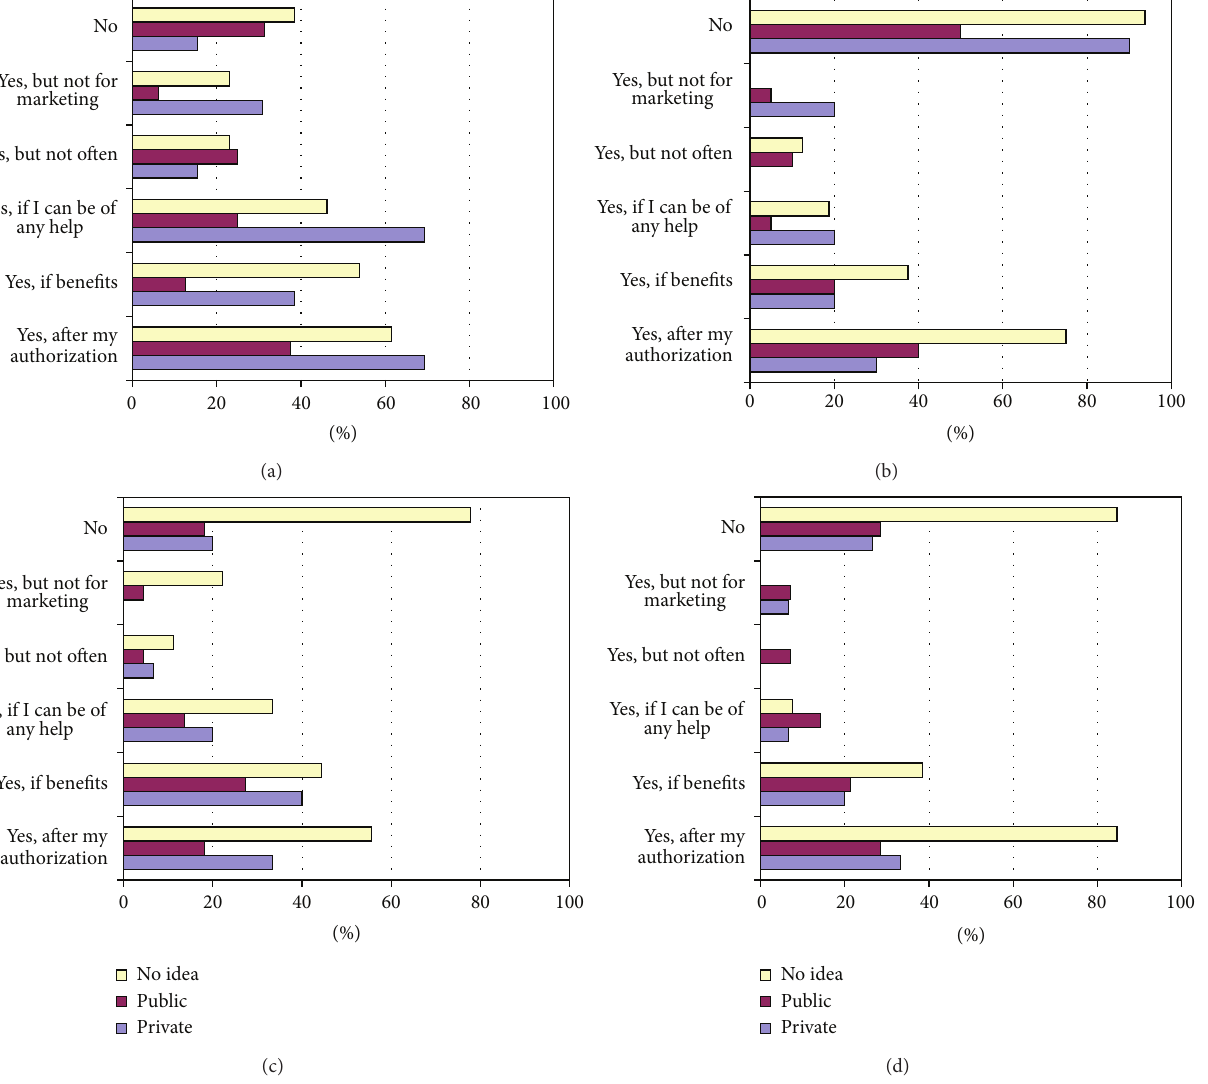
Figure 19: Will to be contacted according to the profile type: (a) DN men; (b) DN women; (c) DI men; (d) DI